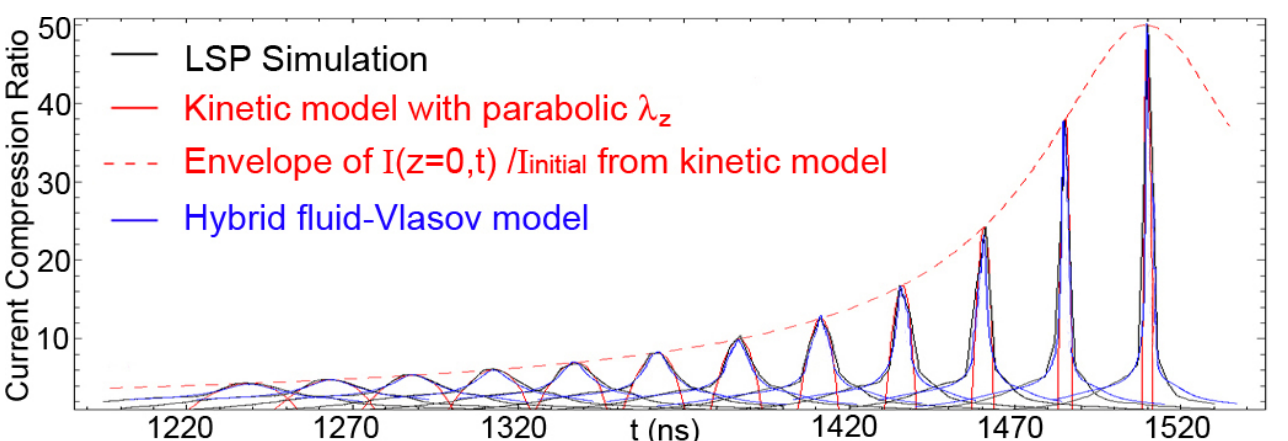
FIG. 9. (Color) Longitudinal compression ratio I (cid:4) t (cid:5) =I in the laboratory frame obtained from the PIC simulation (black), kinetic initial model (red), and hybrid model (blue) at multiple axial locations near the focal plane from Z (cid:8) (cid:2) 77 cm to Z (cid:8) (cid:2) 110 cm